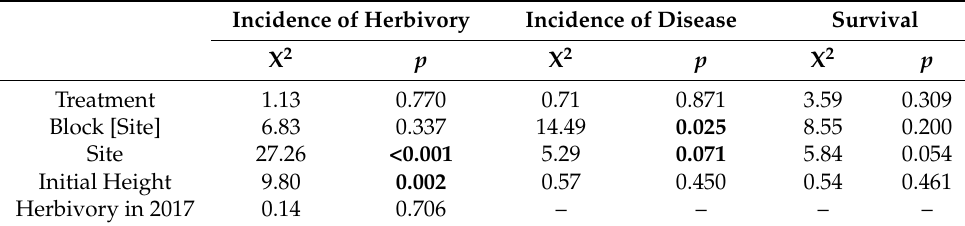
Table 2. Summary statistics for each treatment on the incidence of herbivory and disease, and survival of poison ivy ( Toxicodendron radicans ) plants over the course of the two-year herbivore exclusion study. Treatments included no exclusion, large mammal, small and large mammal exclusion, and full exclusion.